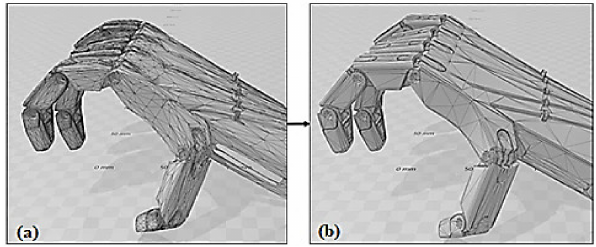
Figure 9. Reduce number of faces from cloud reduction from ( a ) 159,372 and ( b ) 54,000.